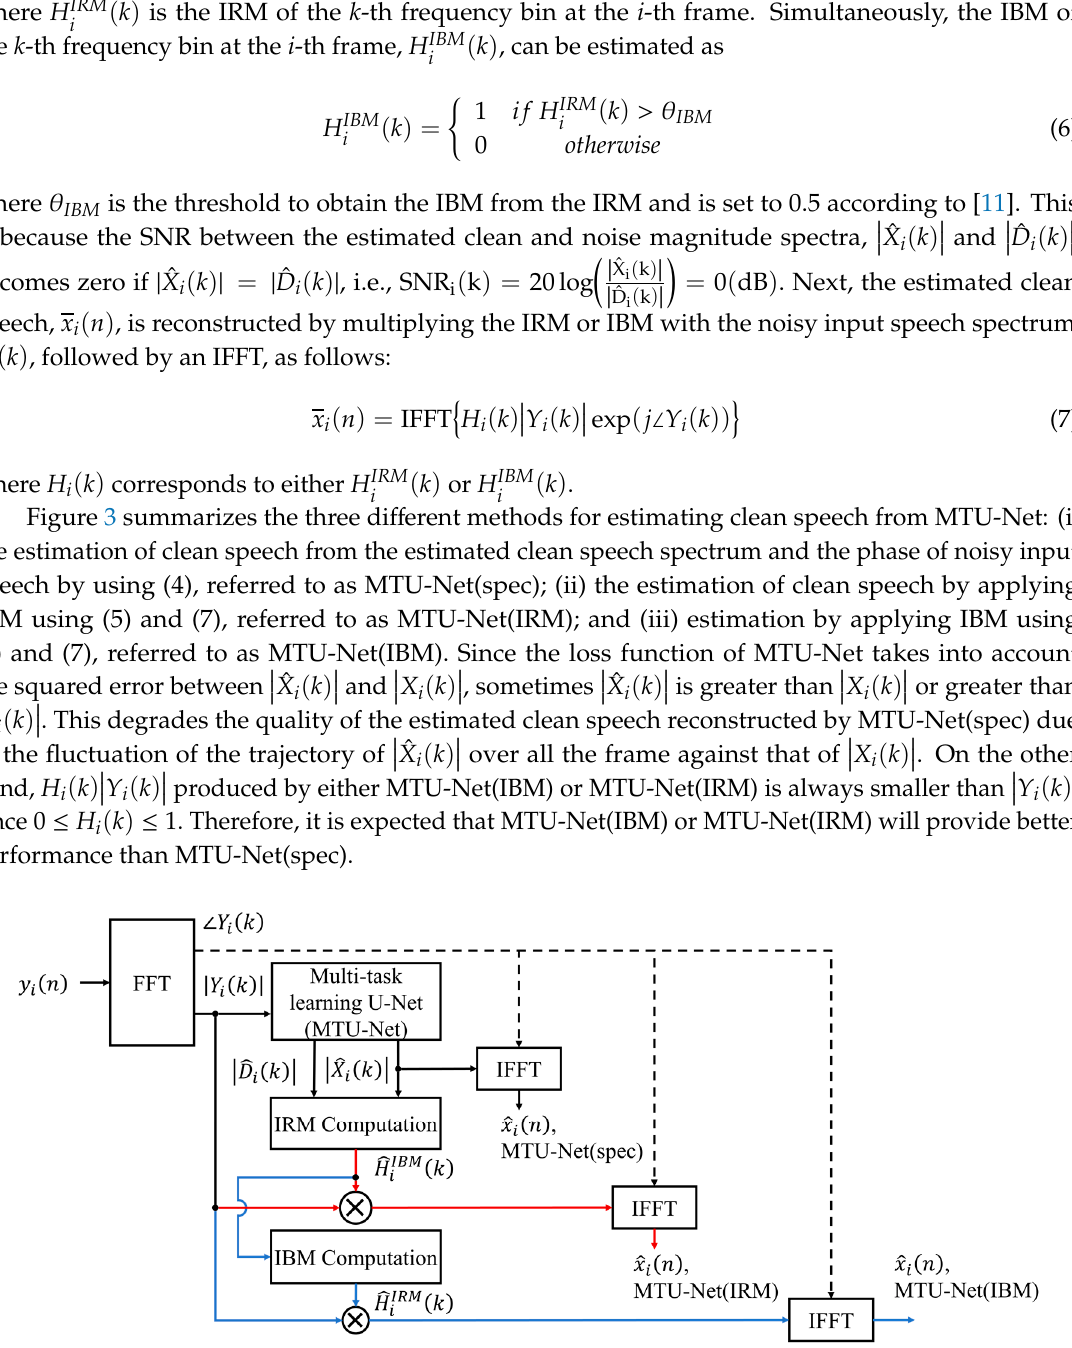
Figure 3. The procedure of obtaining three different estimates of clean speech from the noisy input speech and the outputs of the proposed MTU-Net.